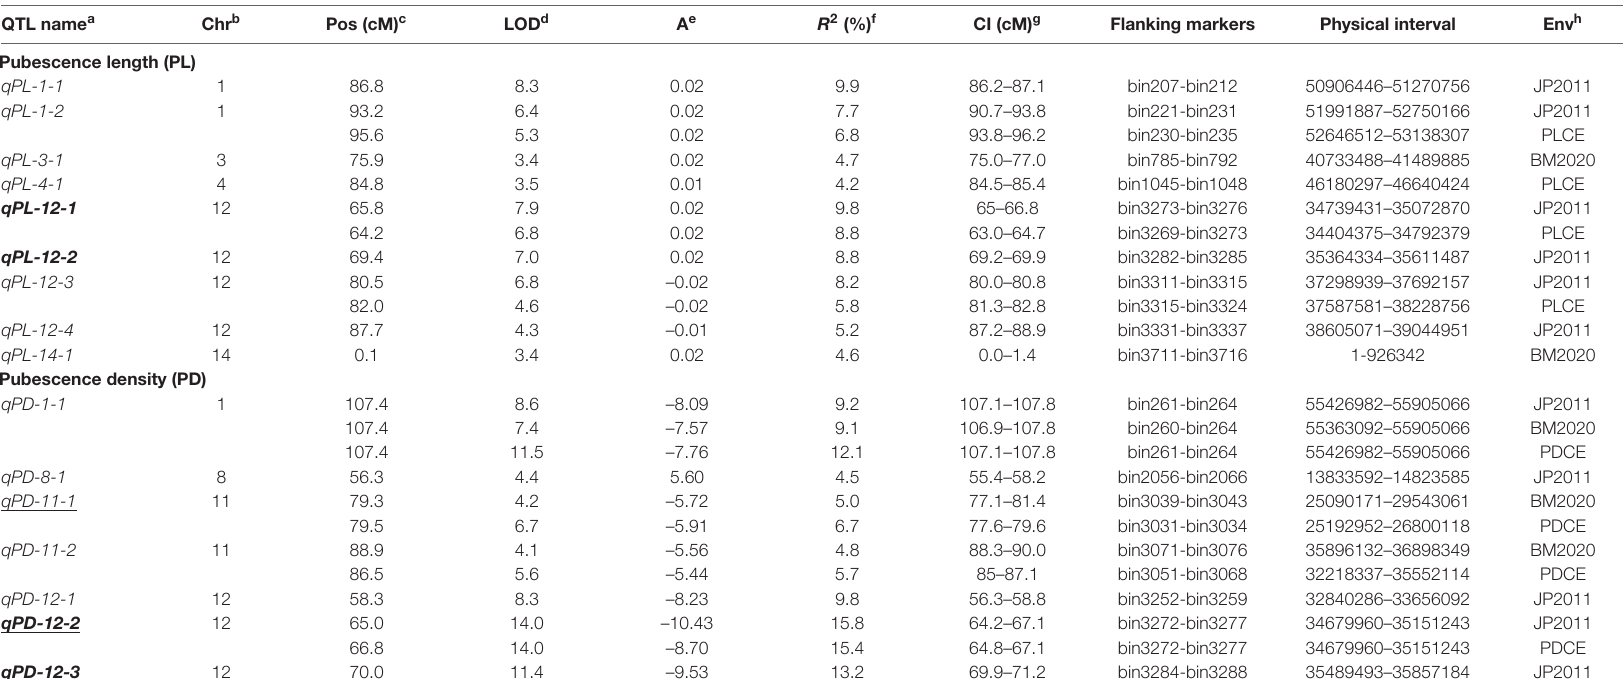
TABLE 2 | The QTLs identified for pubescence length and density in the inter-specific RIL population (NJRINP) with composite interval mapping (CIM)